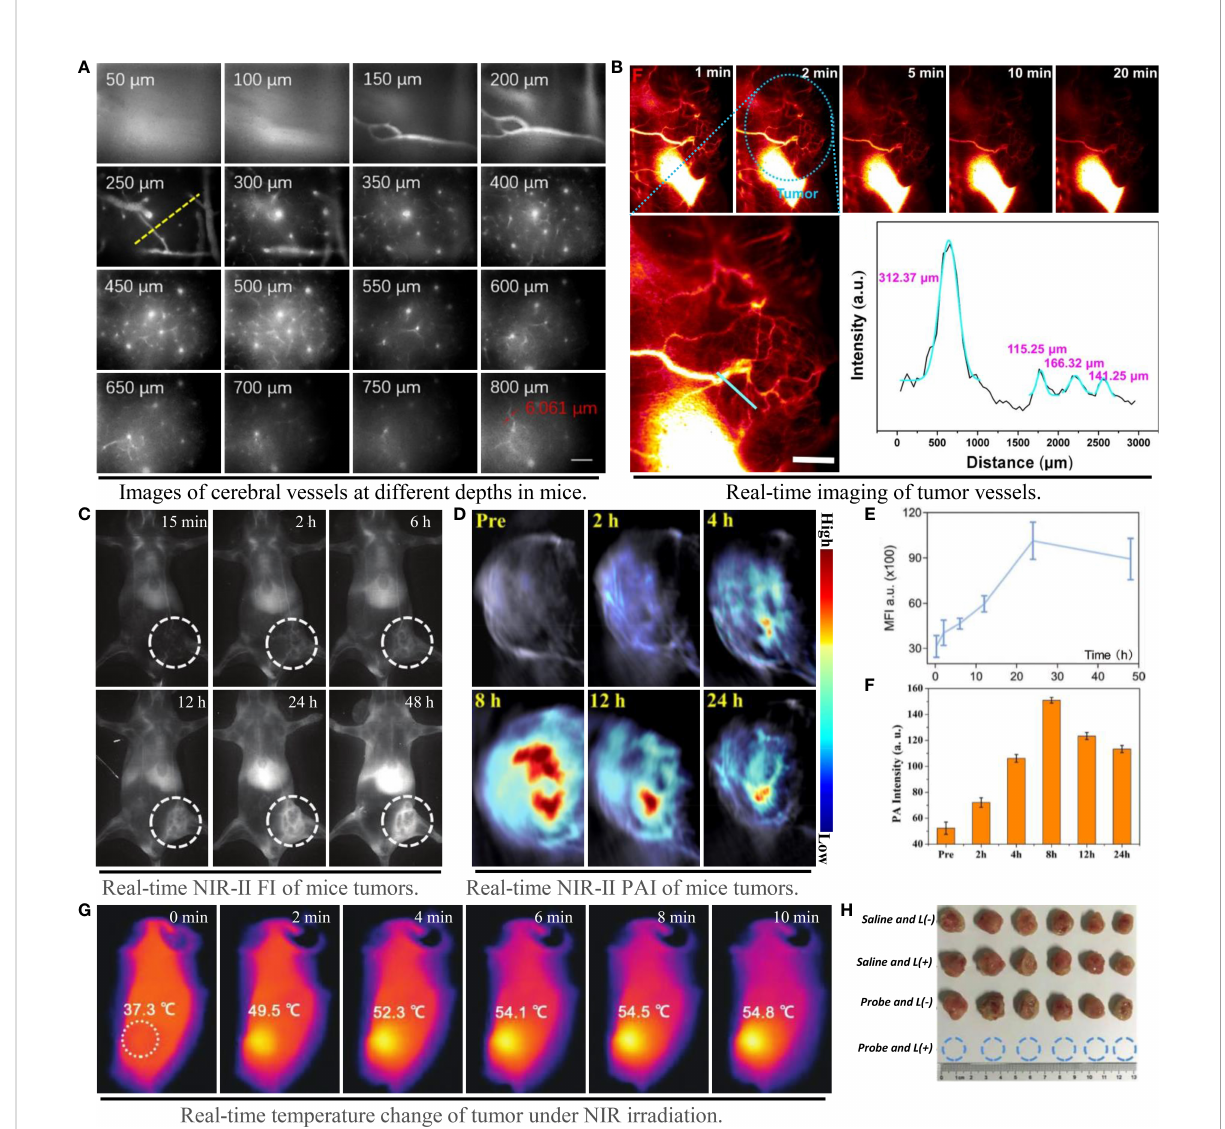
FIGURE 5 Imaging capability of NIR-II probe on blood vessels and tumors, and effect of photothermal therapy. (A) Probe IR-820 imaging of cerebral blood vessels in mice at different tissue depths (scale bar: 100 m m) (50); (B) High resolution imaging of tumor vessels at magni fi cation and gaussian fi tting curve of vessel cross section (scale bar: 2 mm) (29); (C – E) NIR-II fl uorescence imaging and fl uorescence intensity of mouse tumors at different time points (31); (D – F) NIR-II photoacoustic imaging and photoacoustic intensity of mouse tumors at different time points (26); (G) Tumor temperature changes at different time points under NIR laser irradiation (18); (H) Tumor photos and volume changes after photothermal treatment under different conditions, from top to bottom: 1) saline; 2) saline + laser; 3) TSSI NPs; 4) TSSI NPs + laser